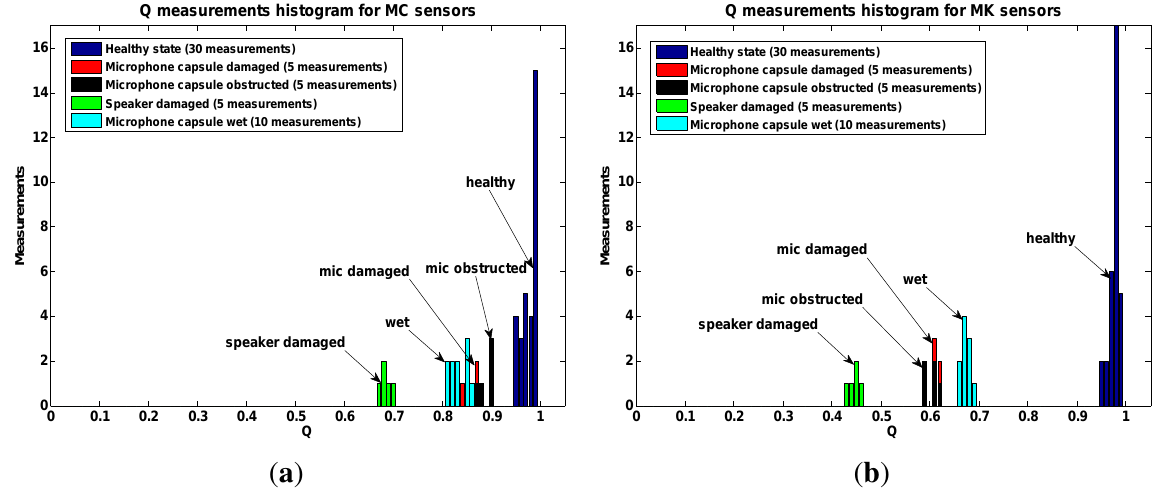
Figure 9. We subjected several MC and MK self-test noise sensors to different failure conditions: wet, broken and obstructed microphone capsules and broken speakers. The produced Q values for the MK sensors were more sensitive to these failure conditions in comparison with the MC sensors. ( a ) MC self-test sensors Q values in failure conditions can get rather close to the healthy median ( M self-test sensors Q values in failure conditions are farther away from the healthy median = 0 . 9789 , blue bars). ( M h